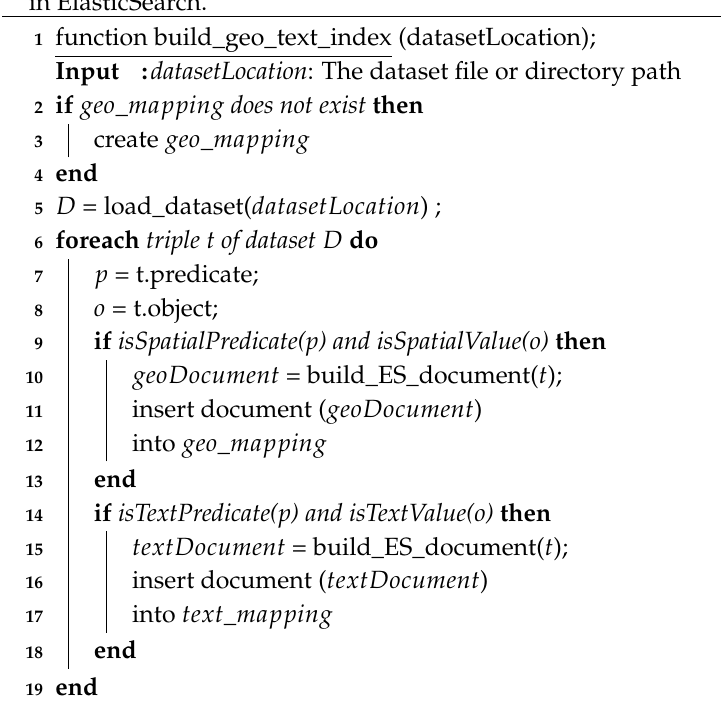
Algorithm 1: A procedure that will read a given dataset and index its spatial and text data in